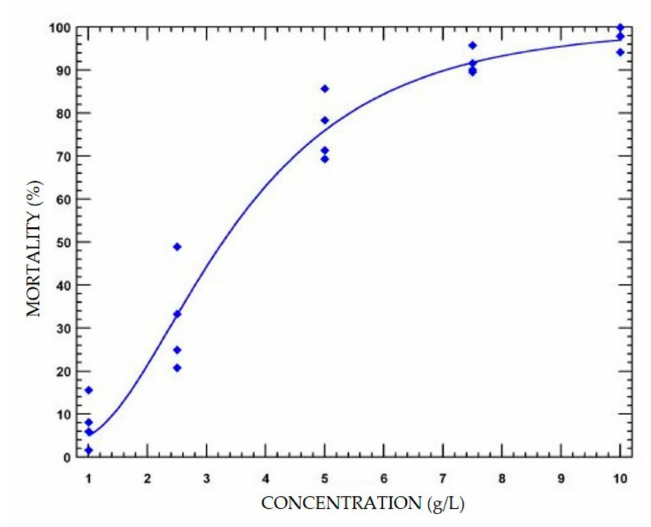
Figure 2. Fitted linear concentration response curve of mortality percentages in Aedes aegypti 2nd instar larvae (n = 4) exposed to DL-methionine for 48-h in glass jars. Each data point represents a replicate with the four jars combined. Curve plotted with PoloPlus (PoloPlus 1.0; LeOra Software, El Cerrito, CA, USA).